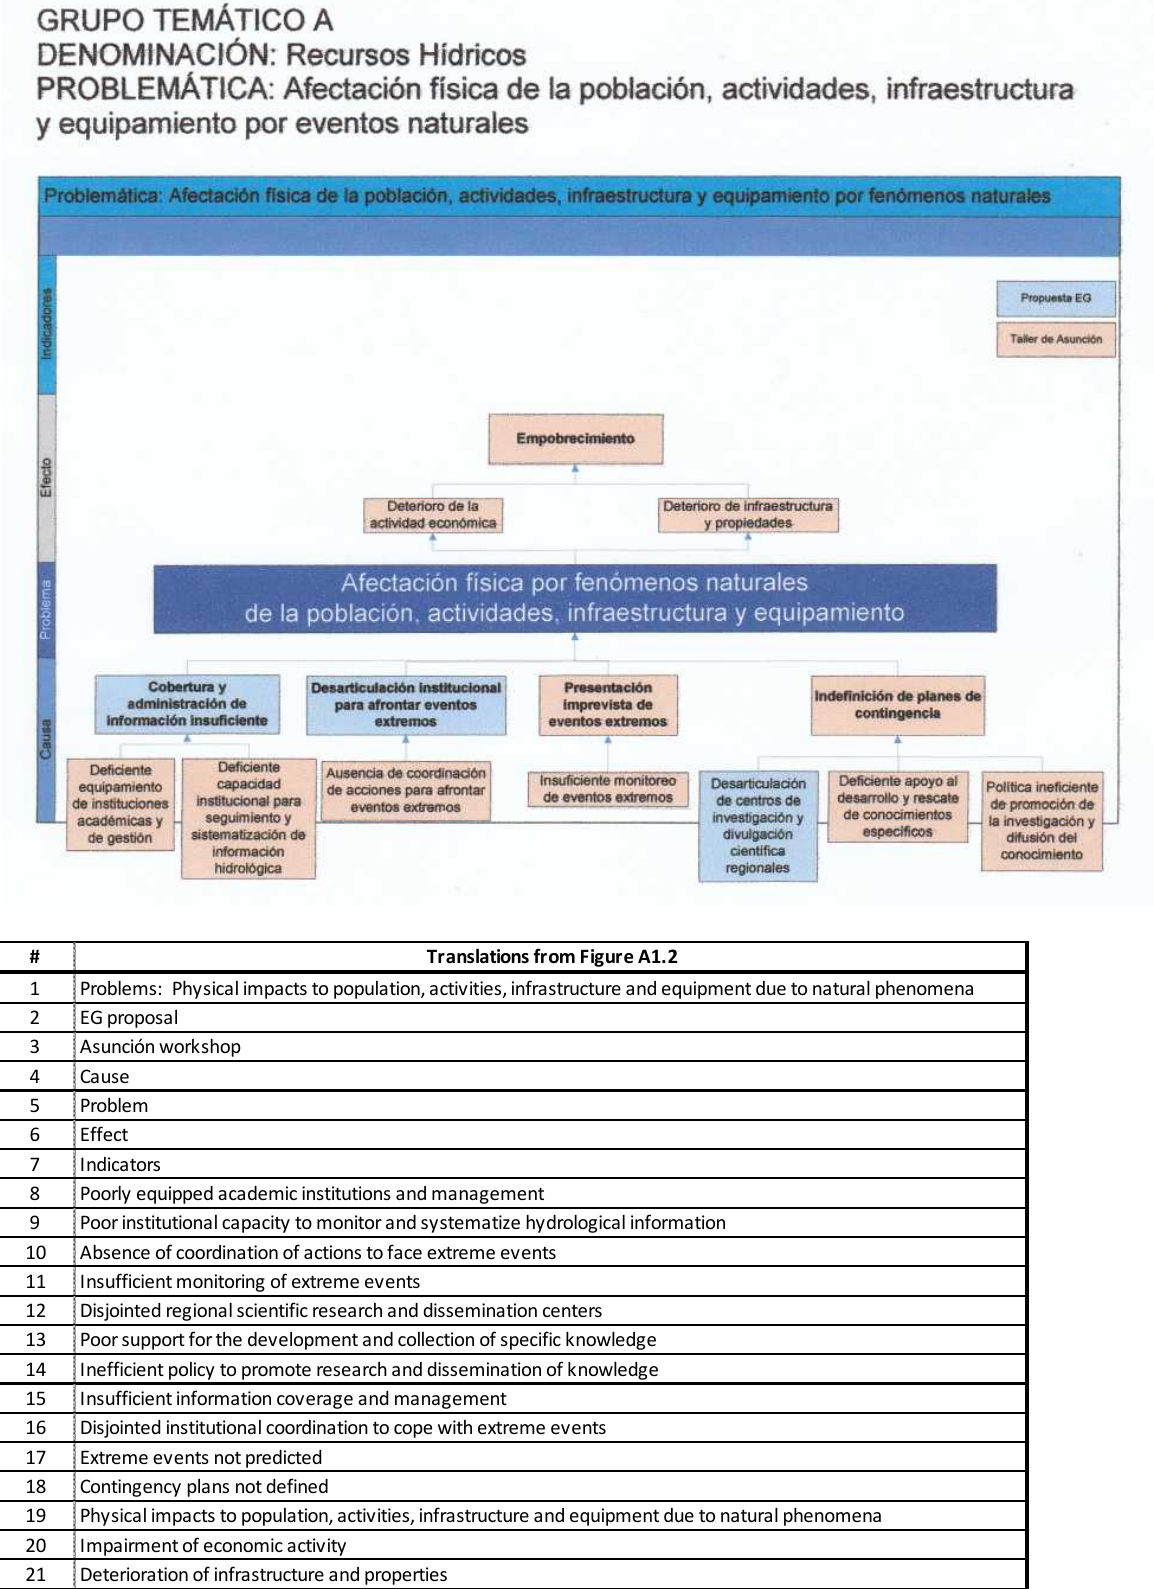
Translations from Figure